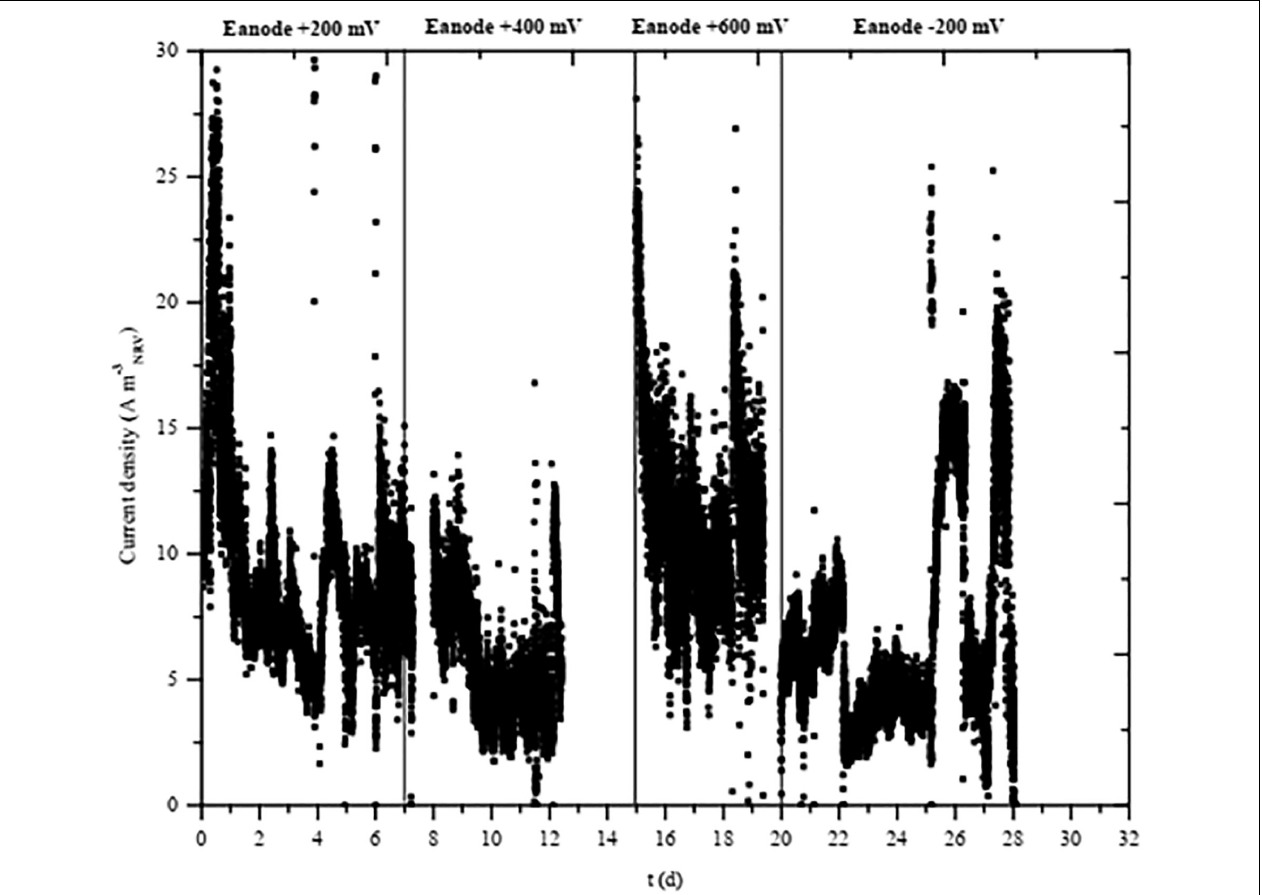
FIGURE 3 | Current density during the long-term operation of the ME-FBR at periods where anode was polarized at the labeled potentials ( − 200, 200, 400, and 600 mV). Symbols: (cid:4) current density (A m − 3 NRV